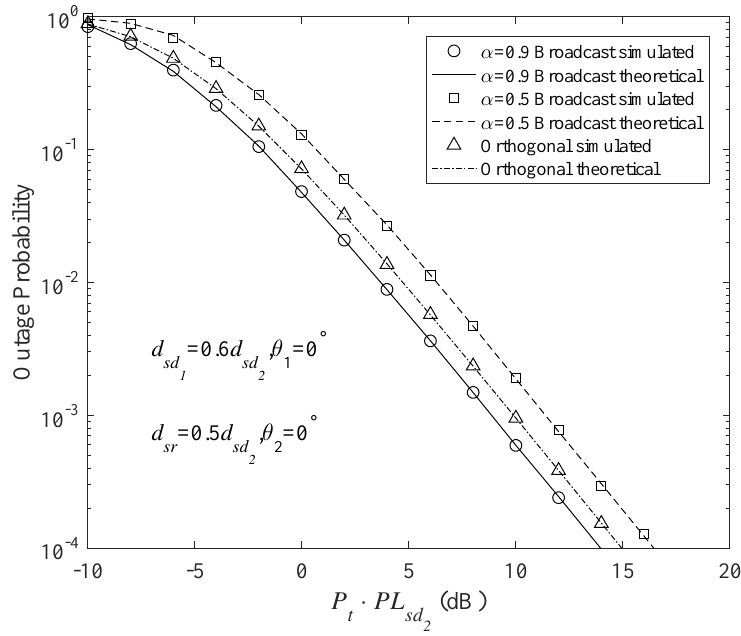
Figure 6. Outage probability of different AF protocols at N d ( τ 1 = τ 2 = 2 b/s/Hz for the orthogonal multiplexing), and transmit powers P r = P s .